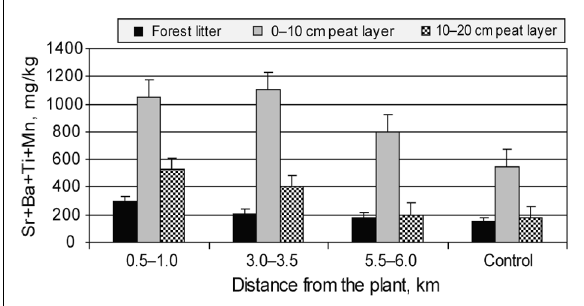
Fig. 3. Microelement (strontium, barium, titanium, manganese) content in peat soil in vicinity of “Akmenės